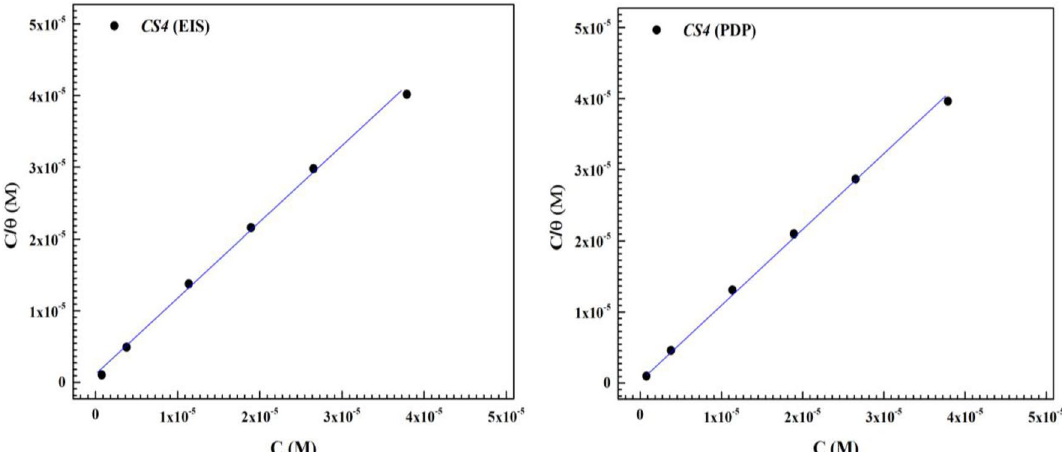
Figure 8. The linear form of Langmuir adsorption isotherm for CS4 on CS -metal surface in 1 M HCl based on EIS and PDP data at room temperature.